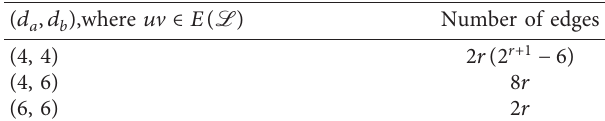
Table 4: Partition of edge set of TB ( r ) built on the degree of end vertices of each edge.